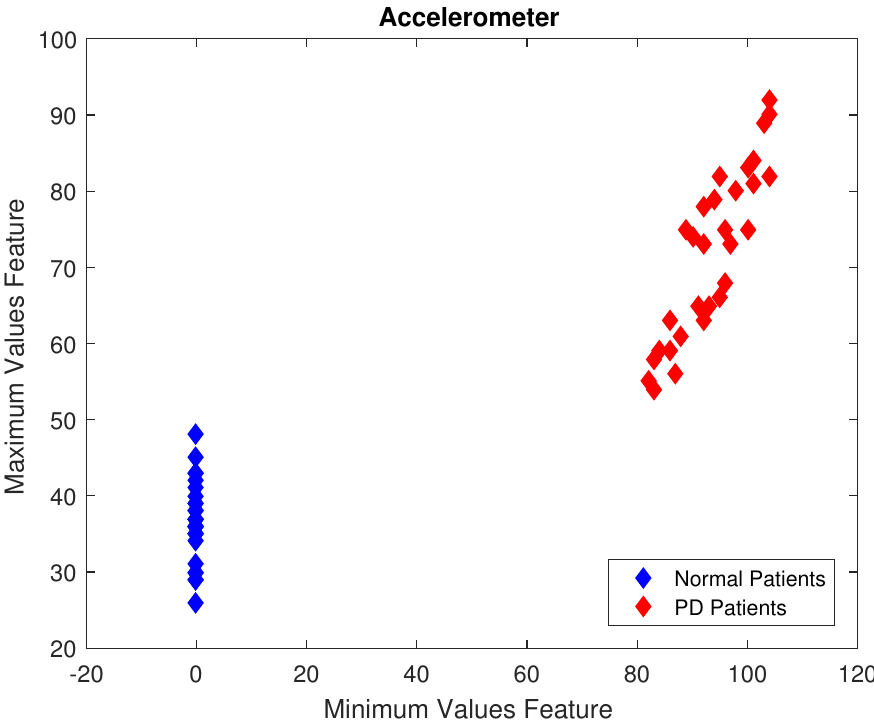
Figure 10. Two-dimensional scatter plot of the maximum value feature vs. the minimum value feature of wrist accelerometer sensor for normal and PD patients.